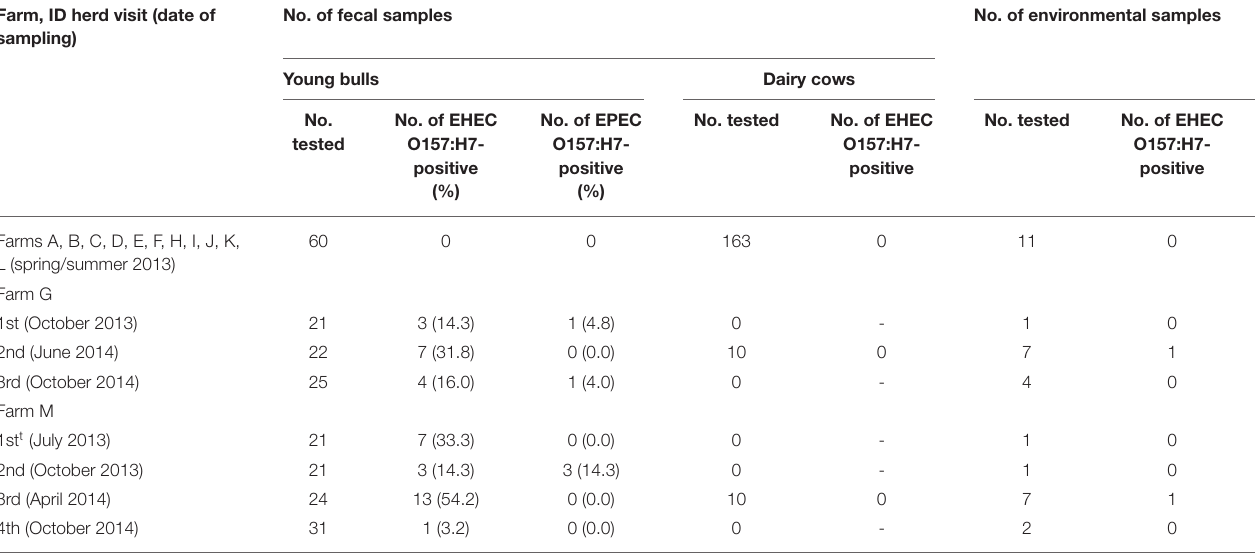
TABLE 1 | Number of fecal and environmental samples tested and number of positive samples per herd visit. Farm, ID herd visit (date of sampling)